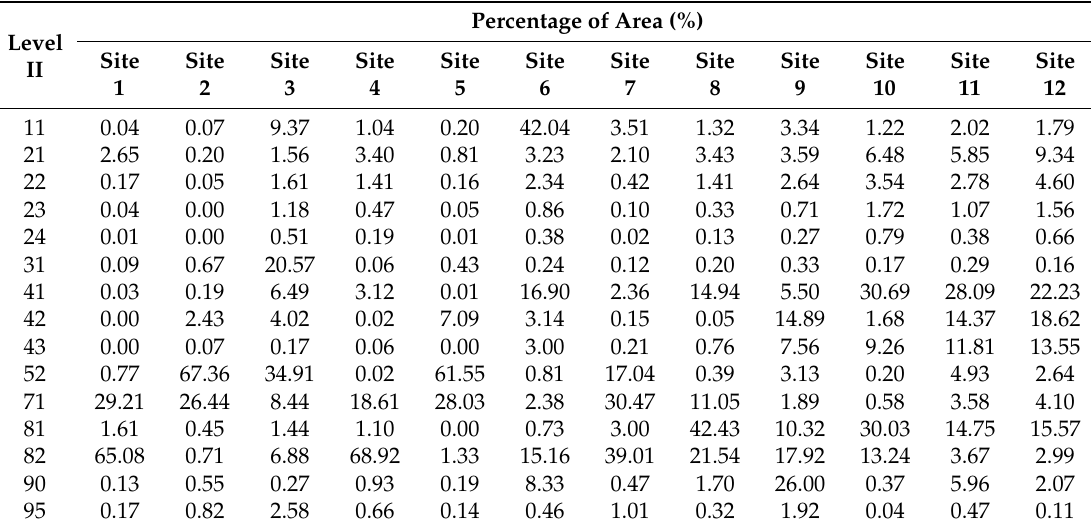
Table 5. Percentage of each thematic class for the twelve study sites using the level II classification scheme (15 classes).